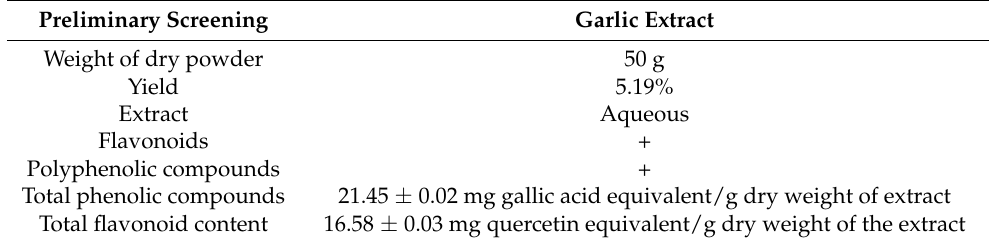
Table 1. Chemical and biological studies of aqueous garlic extract.